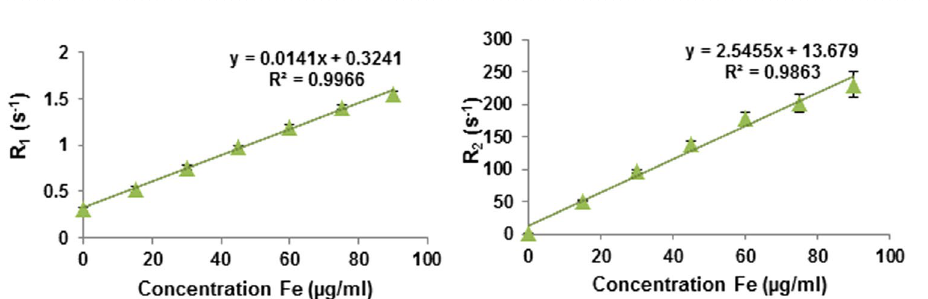
Figure 6. Left plot of relaxation rate R 1 (R 1 = 1/T 1 ) over Fe concentration of the IONP-DHCA nanoparticles in solution. The slope indicates the specific relaxivity (r 1 ); right plot of relaxation rate R 2 (R 2 = 1/T 2 ) over Fe concentration of the IONP-DHCA nanoparticles in solution. The slope indicates the specific relaxivity (r 2 ). Relaxivity values have been converted to mM − 1 s − 1 using the molar mass of iron (M = 55.845